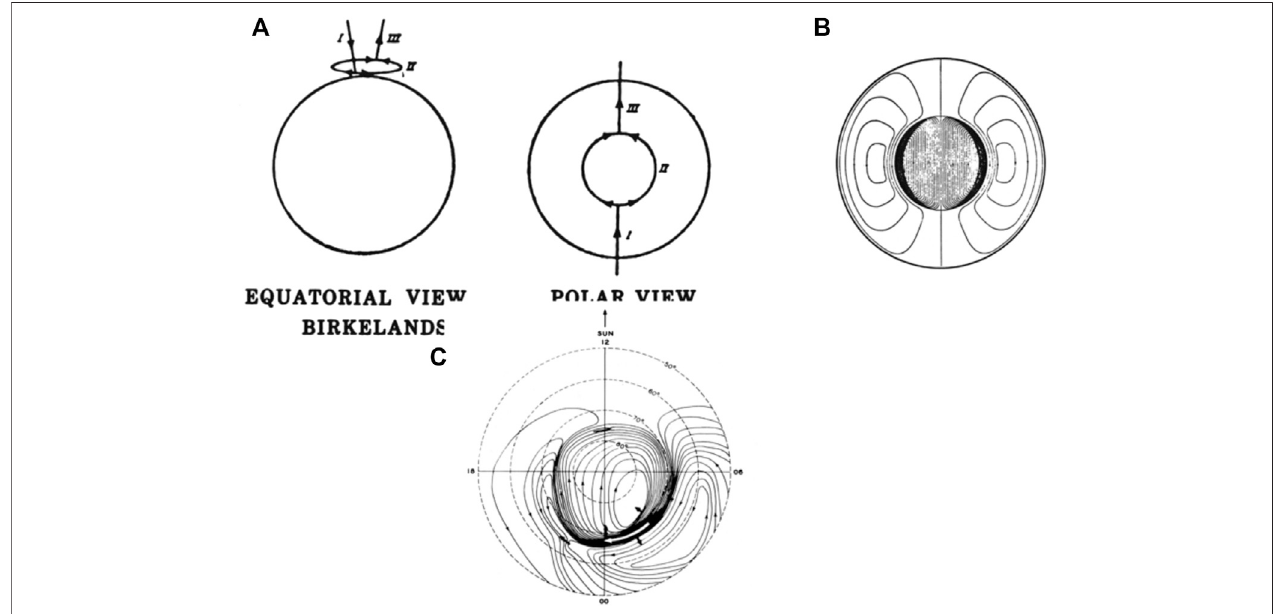
FIGURE 4 | (A) Birkeland ’ s 3-D current system. (B) Chapman ’ s SD current. (C) The current proposed by Akasofu et al. (1965); note that the main current fl ows alongtheauroraloval,notalongtheauroralzone.Notealsothatunlikethetwo-cellSDcurrent (B) ,itisasinglecellcurrent,asdiscussedindetailin TheUnloadingCurrent System